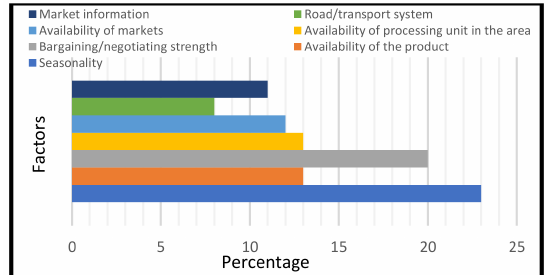
Figure 17. Factors affecting the seed price.